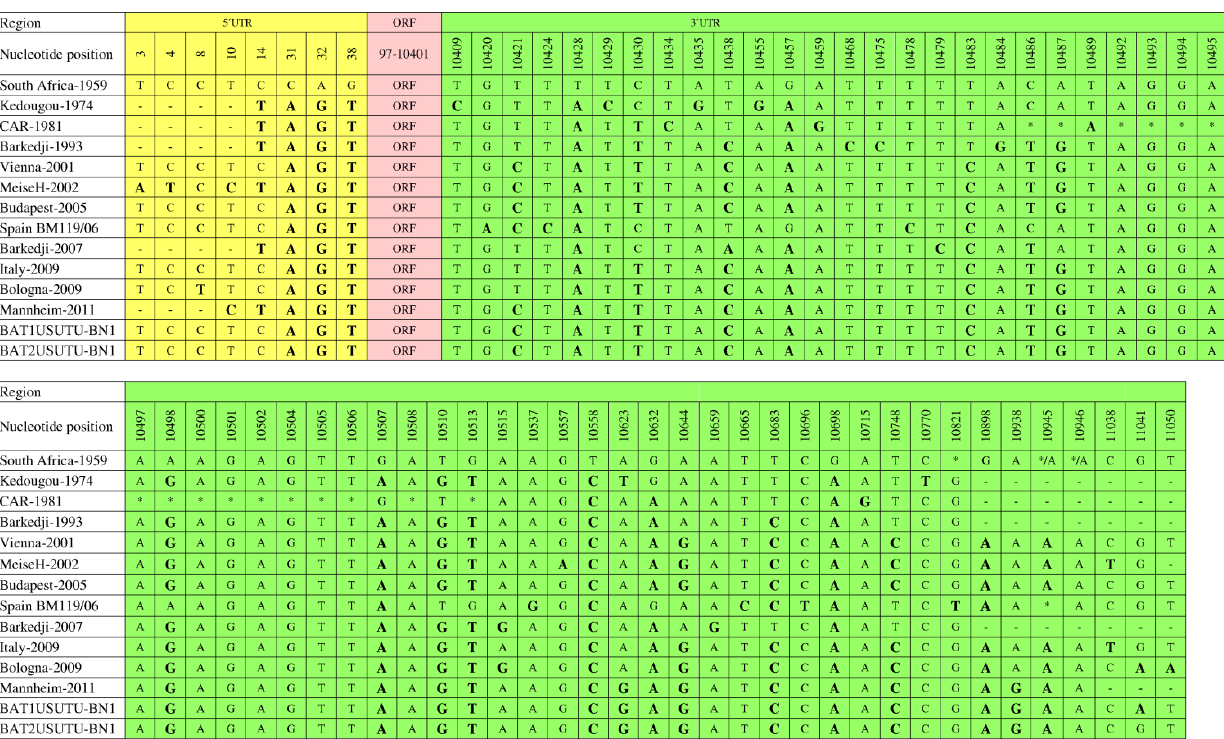
Figure 5. Comparison of 5ʹ UTRs and 3ʹ UTRs of fully sequenced USUV strains. 5ʹ UTR (1–96), open reading frame (ORF;97–10,401), 3ʹ UTR (10,402–11,064). All nucleotide substitutions are shown with bolded and enlarged letters. Nucleotide deletions are indicated by an asterisk